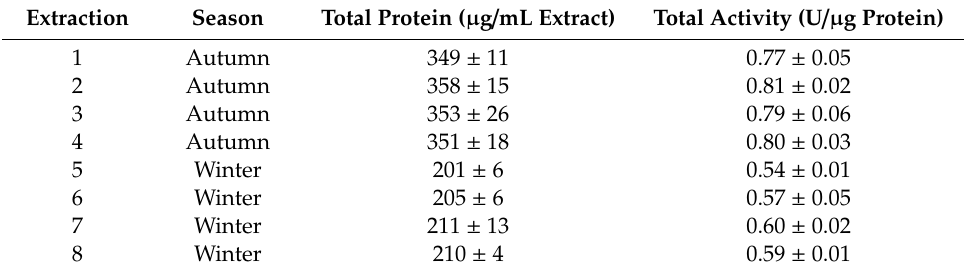
Table 1. Total amount of protein present on the enzymatic extract obtained from turnip roots in different seasons.